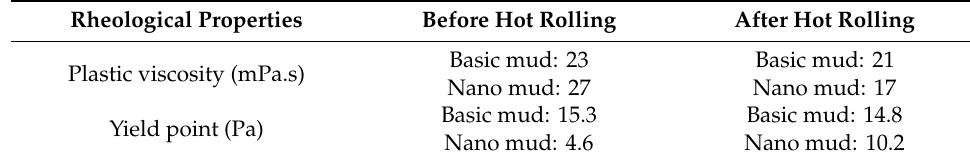
Table 2. Plastic viscosity and yield point of hydrophilic gilsonite nanoparticles (HGN) before and after hot rolling at 422 K [128].